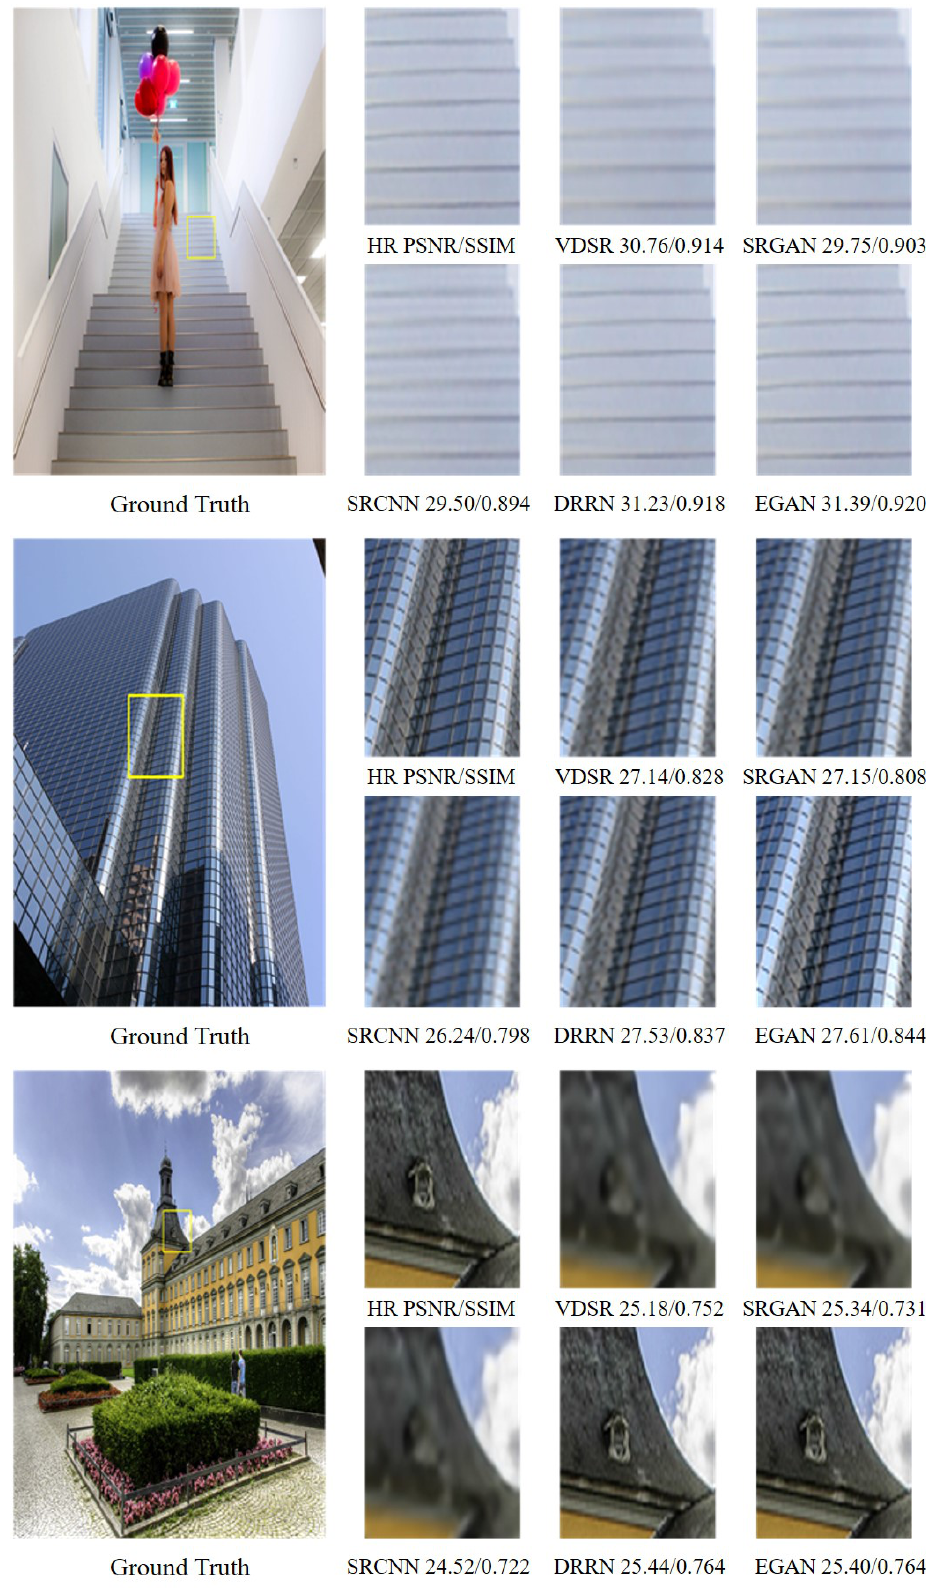
Figure 10. Visual comparisons for ×2, ×3, and ×4 SR on BSD100, image “img009” with scale factor ×2, image “img007” with scale factor ×3, and image “img077” with scale factor ×4 are shown, respectively, in the 3